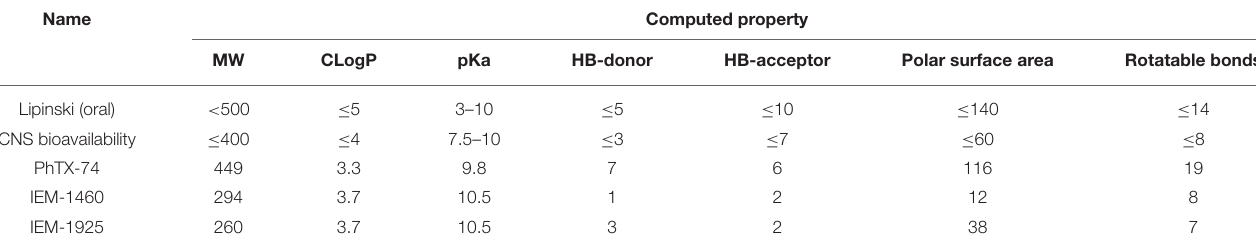
TABLE 2 | Physicochemical properties for